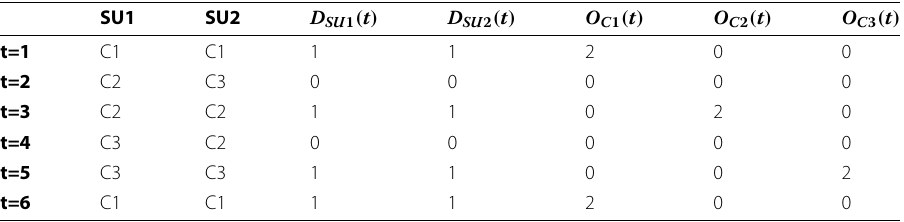
Table 4 Two SUs access three available